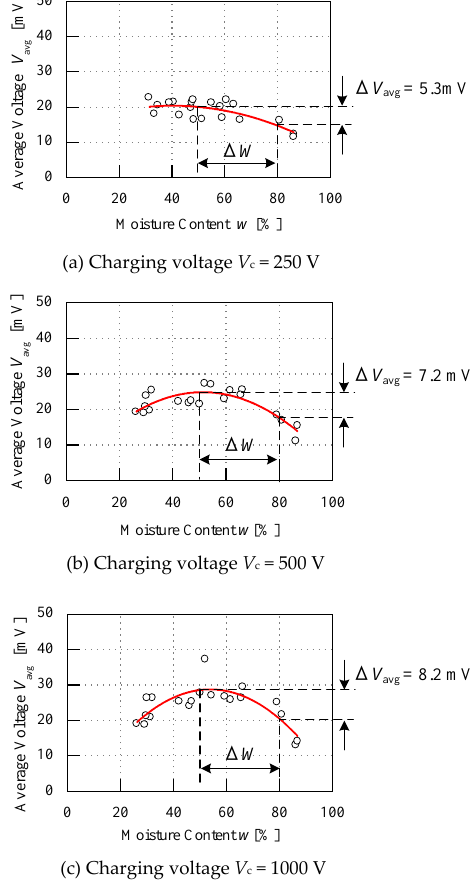
Figure 8. Graph of different voltage injection.